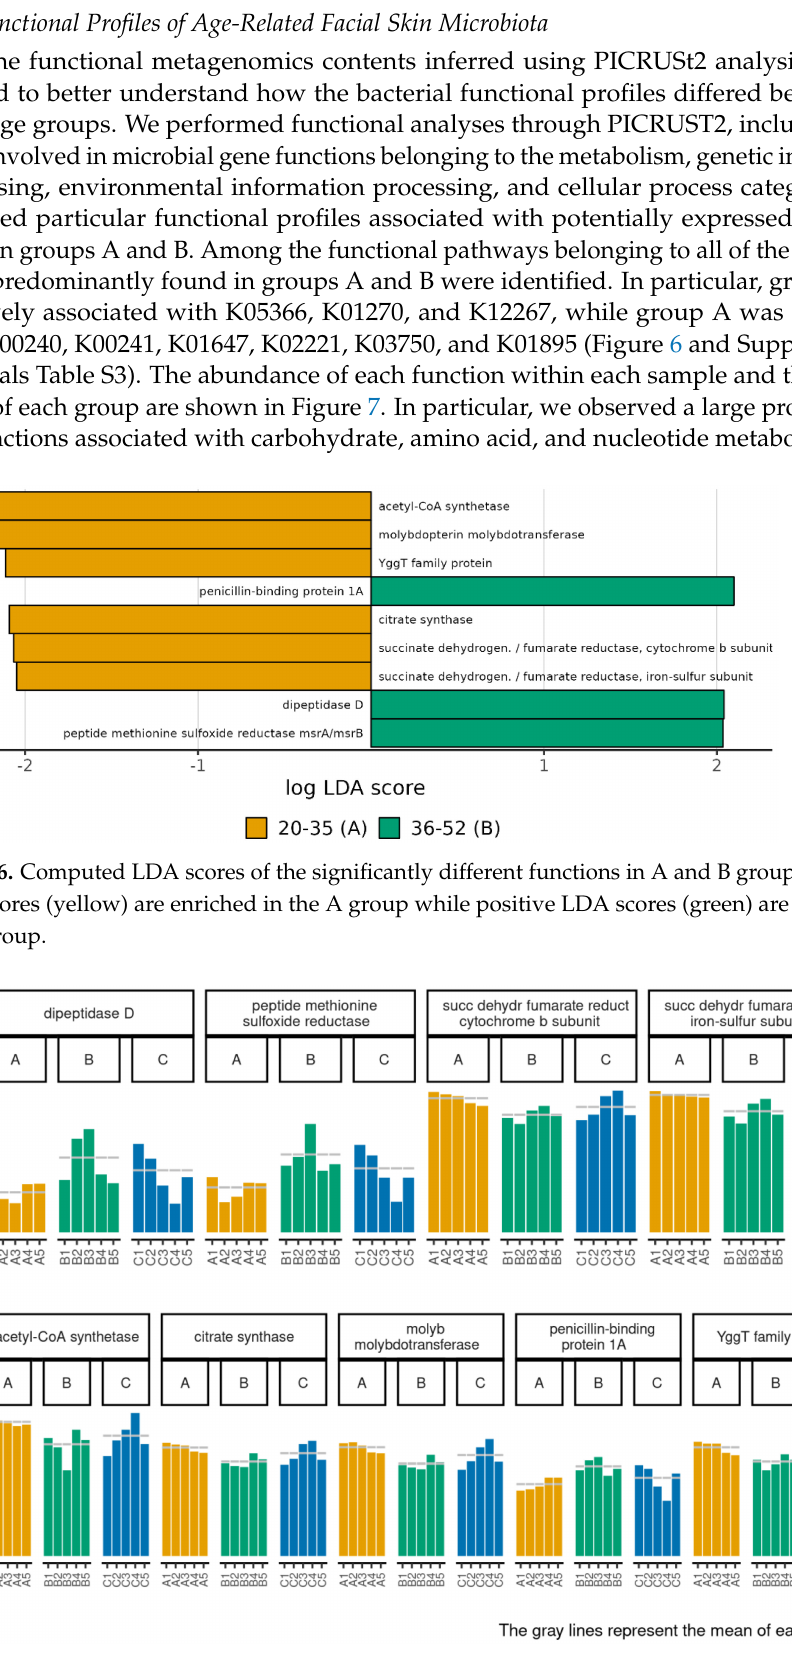
Figure 7. The abundance of each significantly different function in groups A, B, or C within each sample inferred by PICRUSt2. The grey lines represent the mean of each